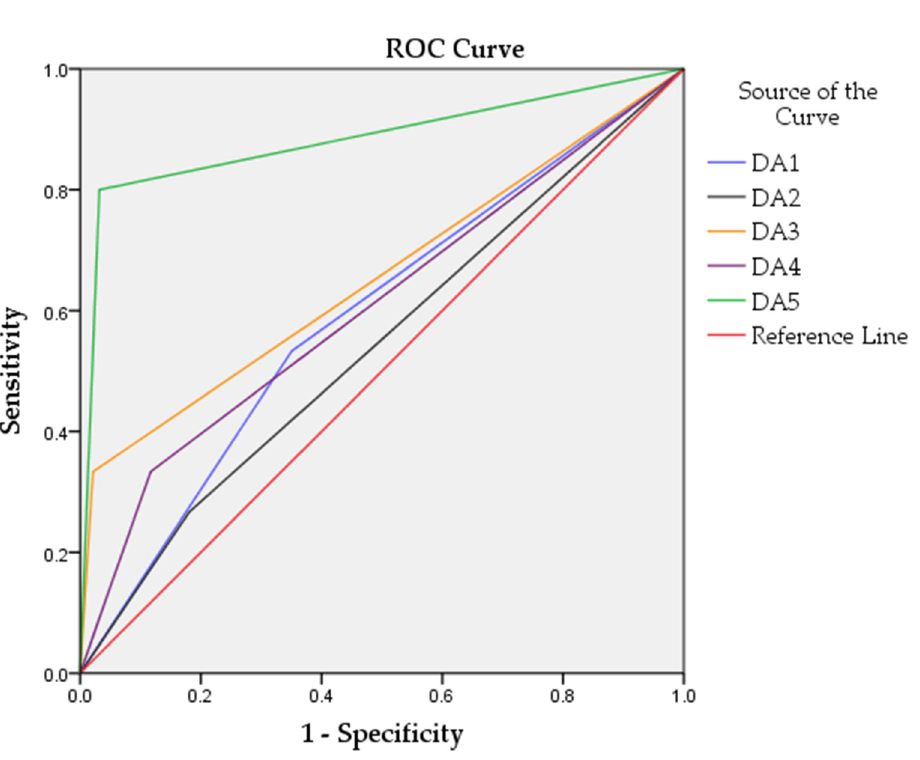
Figure 3. Performance of the discriminant function analyses models with different sets of biomarkers. ROC curves are represented in different colors for each model.